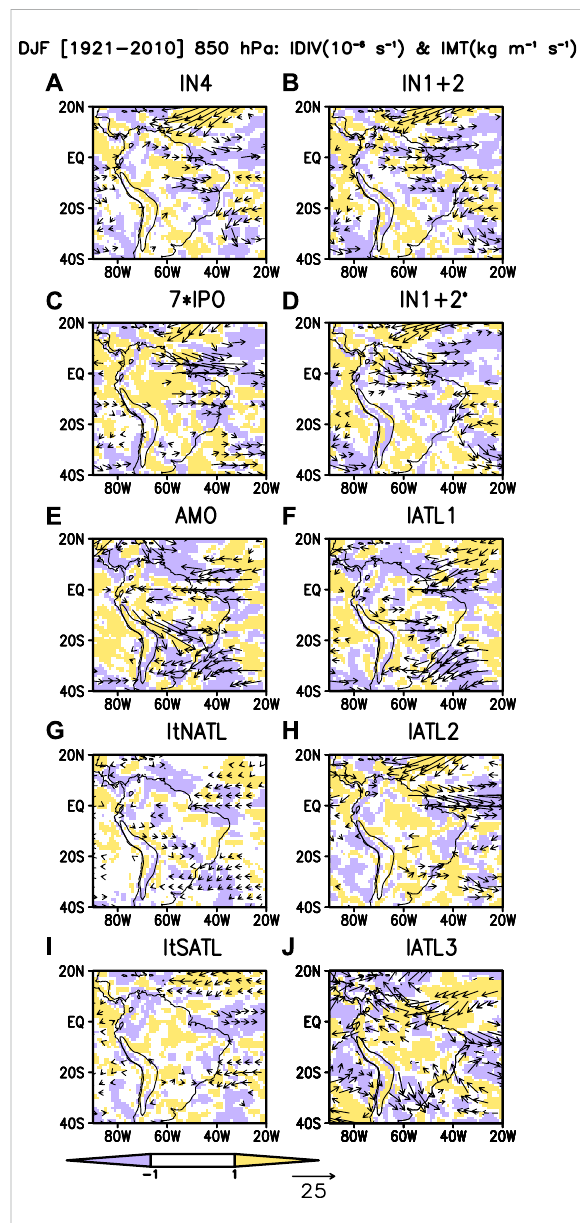
FIGURE 6 Linear regression coef fi cients between interdecadal component of the DJF humidity transport and divergence anomalies over South America at 850 hPa and (A) the Interdecadal Niño 4 (IN4), (B) Interdecadal Niño 1 + 2 (IN1+2) index, (C) Interdecadal Paci fi c Oscillation (IPO), (D) Interdecadal Niño 1 + 2 with Interdecadal Niño 4removed(IN1+2*), (E) AtlanticMultidecadalOscillation(AMO), (F) fi rst rotated principal component of the interdecadal variability of the Atlantic SST (IATL1), (G) Interdecadal tropical North Atlantic (ItNATL) index, (H) second rotated principal component of the interdecadal variability of the Atlantic SST (IATL2), (I) Interdecadal tropical South Atlantic(ItSATL)index,and (J) thirdrotatedprincipalcomponentofthe interdecadalvariabilityoftheAtlanticSST(IATL3).Valuesareinkg m s − 1 and10 – 6 s − 1 foronestandarddeviationofcorrespondingindices.Black vectors and shading are statistically signi fi cant at the 95% con fi dence level. The black contour represents the topography of the